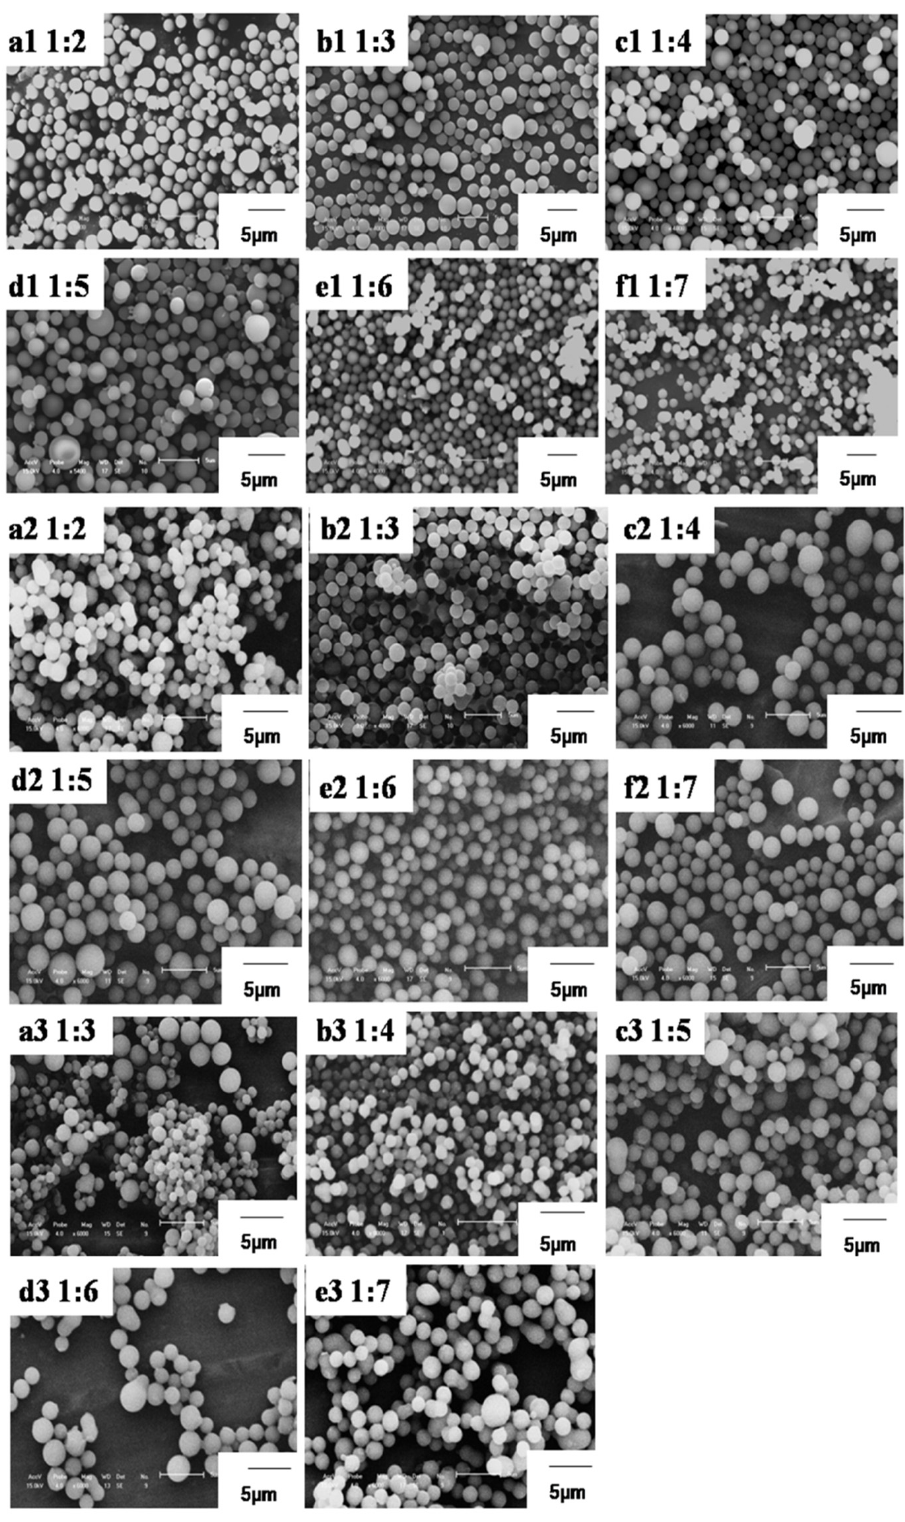
Figure 7. SEM micrographs of the polymeric particles prepared by precipitation polymerization with various molar ratios of HCCP to hydroxybenzene: ( a1 – f1 ) 6FPZF microspheres with molar ratios of HCCP to 6FPH of 1:2 to 1:7; ( a2 – f2 ) 3FPZF microspheres with molar ratios of HCCP to 3FPH of 1:2 to 1:7; ( a3 – e3 ) TPZF microspheres with molar ratios of HCCP to TPH of 1:2 to 1:7.